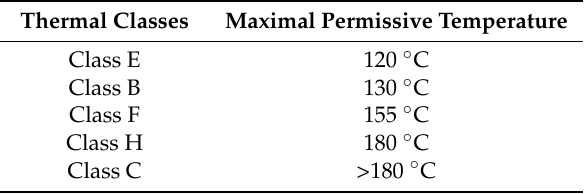
Table 2. Insulation systems are divided into thermal classes having a maximum operating temperature